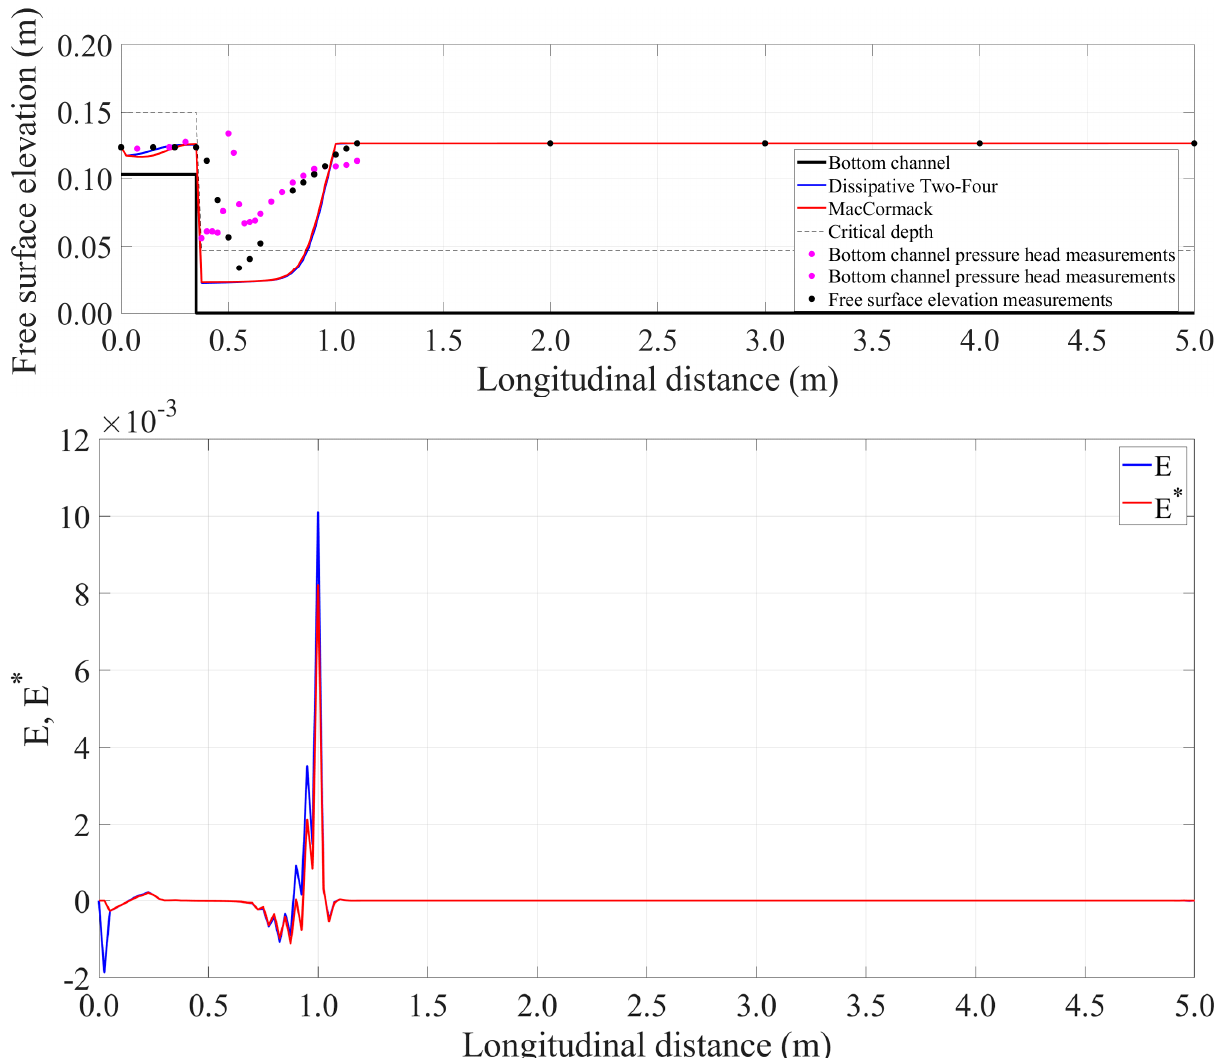
Figure 13. Test case 1: ( Top ) Comparison between the computed free surface profile and the experiment (point gauge and pressure head measurements). ( Bottom ) Numerical results for the Boussinesq term along the channel for the Dissipative Two-Four scheme, prediction and the correction step.